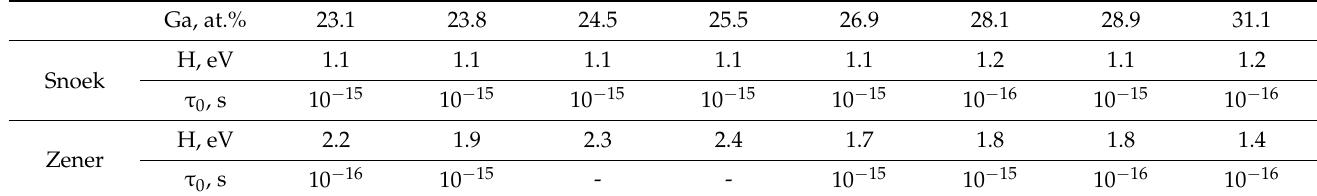
- The relaxation strength of the P2 (Zener) peak depends on %Ga in alloys and is discussed below; - The total height of transient peaks (peak plus background) is approximately constant within accuracy of the measurements 0.05 < Q Tr−1 < 0.06. High temperature background increases with increase in Ga content leading to non-monotonous height of P Tr vs. Ga content. Apparent values of activation energy and characteristic relaxation time for P2 effect have undesirable scattering (see Table 3). The P Tr peak temperature increases slightly (25.5%Ga at 480 °C, 26.1%Ga at 485 °C, 26.9%Ga at 487 °C, and 27.3%Ga at 518 °C), which means that the transition needs higher thermodynamic stimulus. A shift in high- temperature background to lower temperatures with increase in Ga content in alloys also takes place as a consequence of a decrease in solidus temperature of the alloys. Table 3. Apparent values of activation energies (H) and distribution relaxation time (β τ ) for Zener relaxation in Fe–(15–21)Ga alloys [49,59,60]. Values are rounded to tenths. In the alloys with 24.5 and 25.5%Ga, the peak height is very low and evaluation of the activation parameters for these two alloys is not precise.